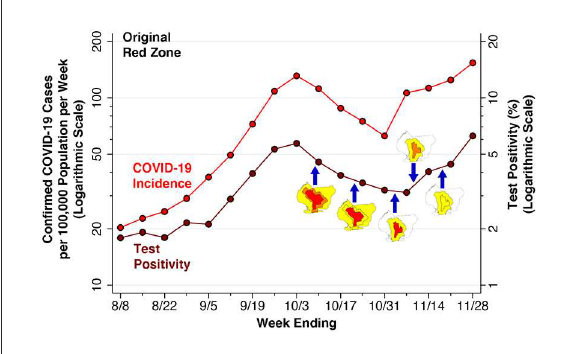
FIGURE5 Confirmed COVID-19 cases per 100,000 population (Left Axis) and Test Positivity rate (Right Axis) in the Original Red Zone, weeks ending 8/8 through 11/28/2020. As in Figure 4, the data points represent population-weighted rates, derived from ZCTA-specific weekly COVID-19 incidence (40) and test positivity (41) among the ZCTAs identified as covering the red zone in Figure 2A. As in Figure 4, the blue arrows show the dates on which the five successive regulatory actions went into effect, while the accompanying maps show the corresponding zone